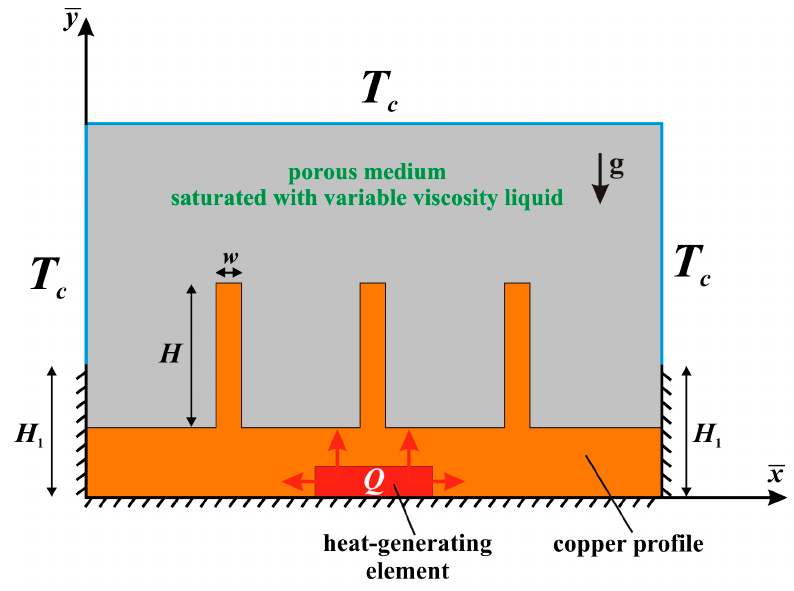
Figure 1. A scheme of the problem.